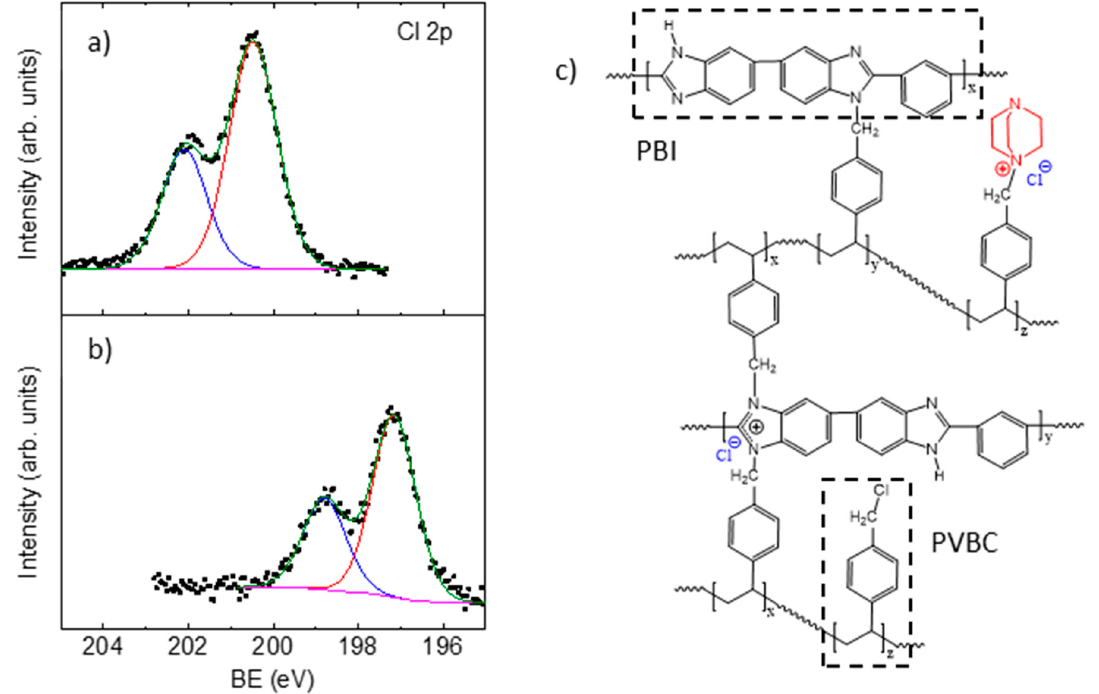
Figure 3. XPS Cl 2p doublet of ( a ) PBI-c-PVBC 1:2 membrane (crosslinked), ( b ) PBI-c-PVBC / Cl 1:2 membrane (after quaternization with DABCO) and ( c ) schematic chemical structure of the membranes.